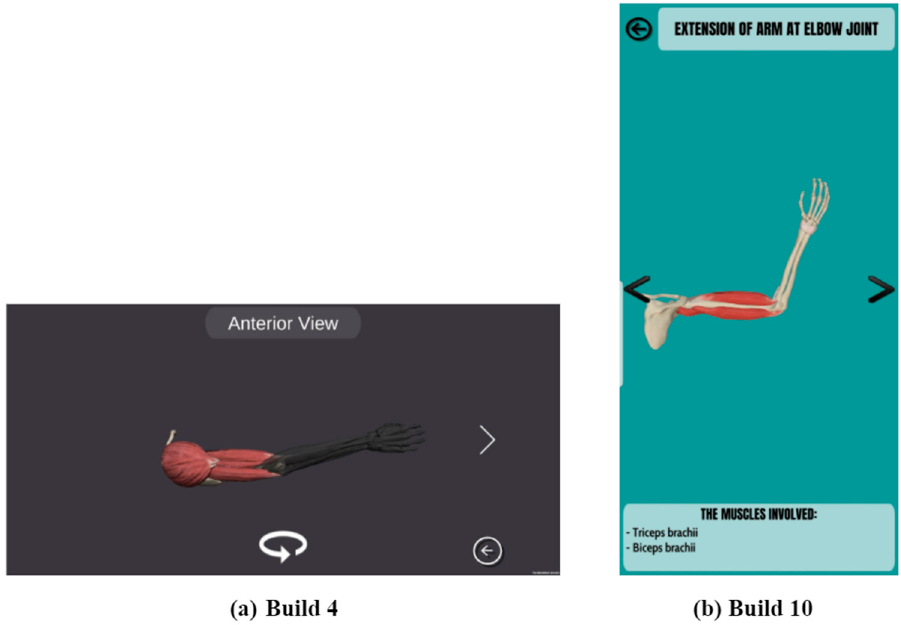
Figure 6. The changes made to the animation feature, including final UI design and placement, during application development.